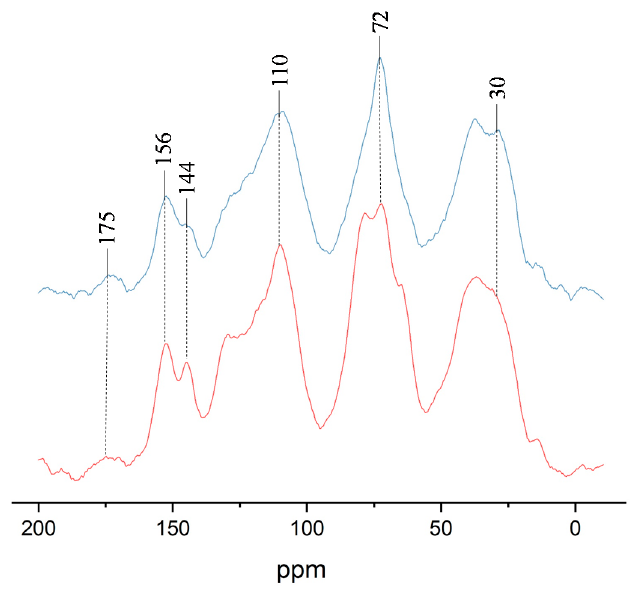
Figure 6. Solid state 13 C NMR spectrum of the insoluble matter of tannin–sucrose–sulfuric acid adhesive with 1.0 pH cured at 160 °C for 10 min (blue) and tannin–sucrose adhesive cured at 220 °C for 10 min (red).